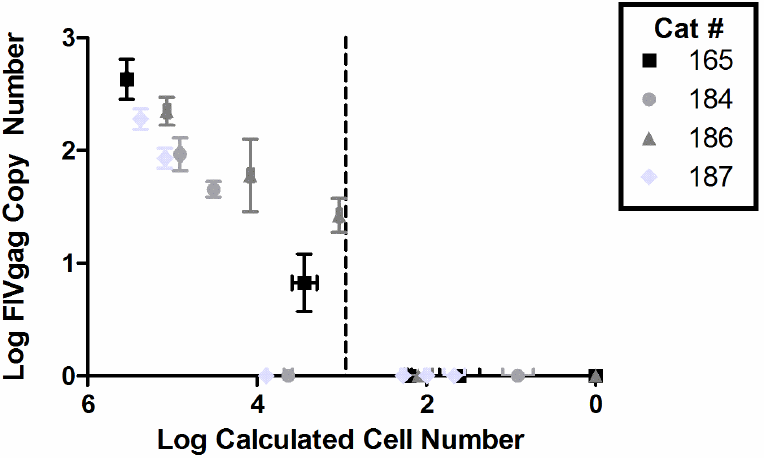
Figure 1. Quantification of feline immunodeficiency virus (FIV) proviral load in CD4+ T- cells. Log FIV gag copy number is plotted against the log of calculated cell number (based on cellular IL2 gene copies divided by 2) for 4 chronically FIV-infected cats (28–32 months post infection). Dashed vertical line represents the average cell number at which the FIV signal falls below detection level (~10 3 cells). Error bars represent the standard deviation of quadruplicate qPCR